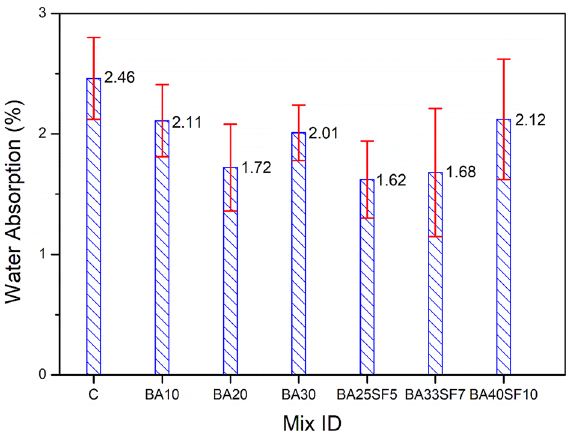
Figure 6. Comparison of water absorption results between control and other concrete samples of binary and ternary mixes after 91 days of standard